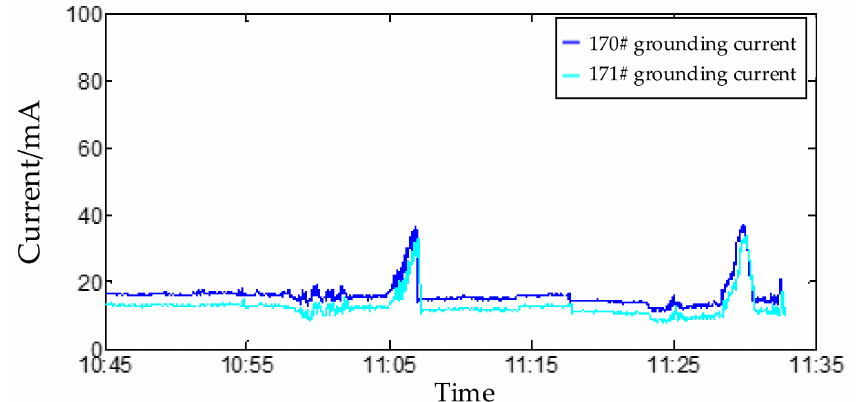
Figure 15. “Nankun 1” 10 kV through line 170#, 171# cable metal sheath grounding current.